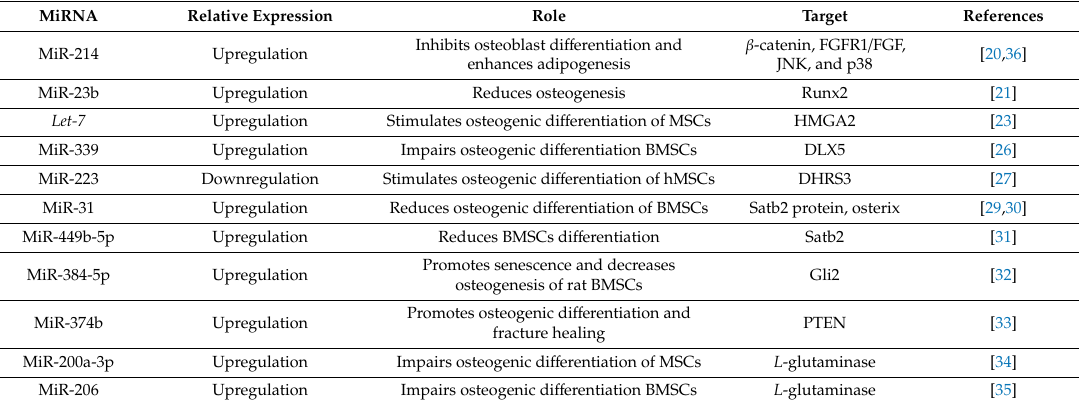
Table 1. Role and target of miRNAs in BMSC